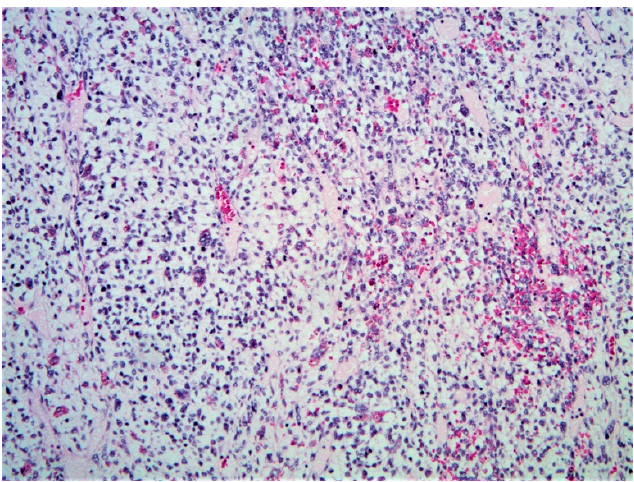
Figure 13. Undifferentiated embryonal sarcoma (H&E, 10× magnification). Sheets of highly pleo- morphic cells with abundant mitotic figures, set in a myxoid stroma.